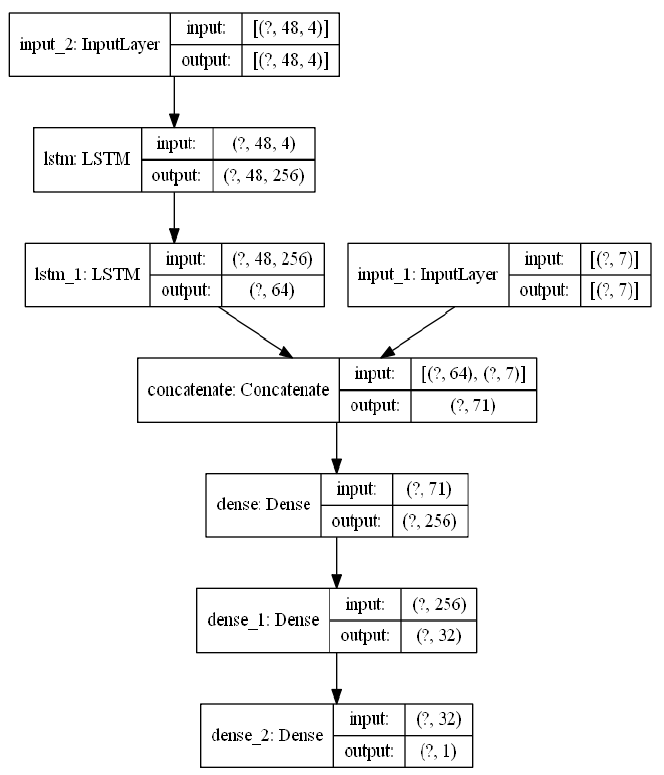
Figure 2. Structure diagram of LSTM-FCN model for predicting 0 aging.